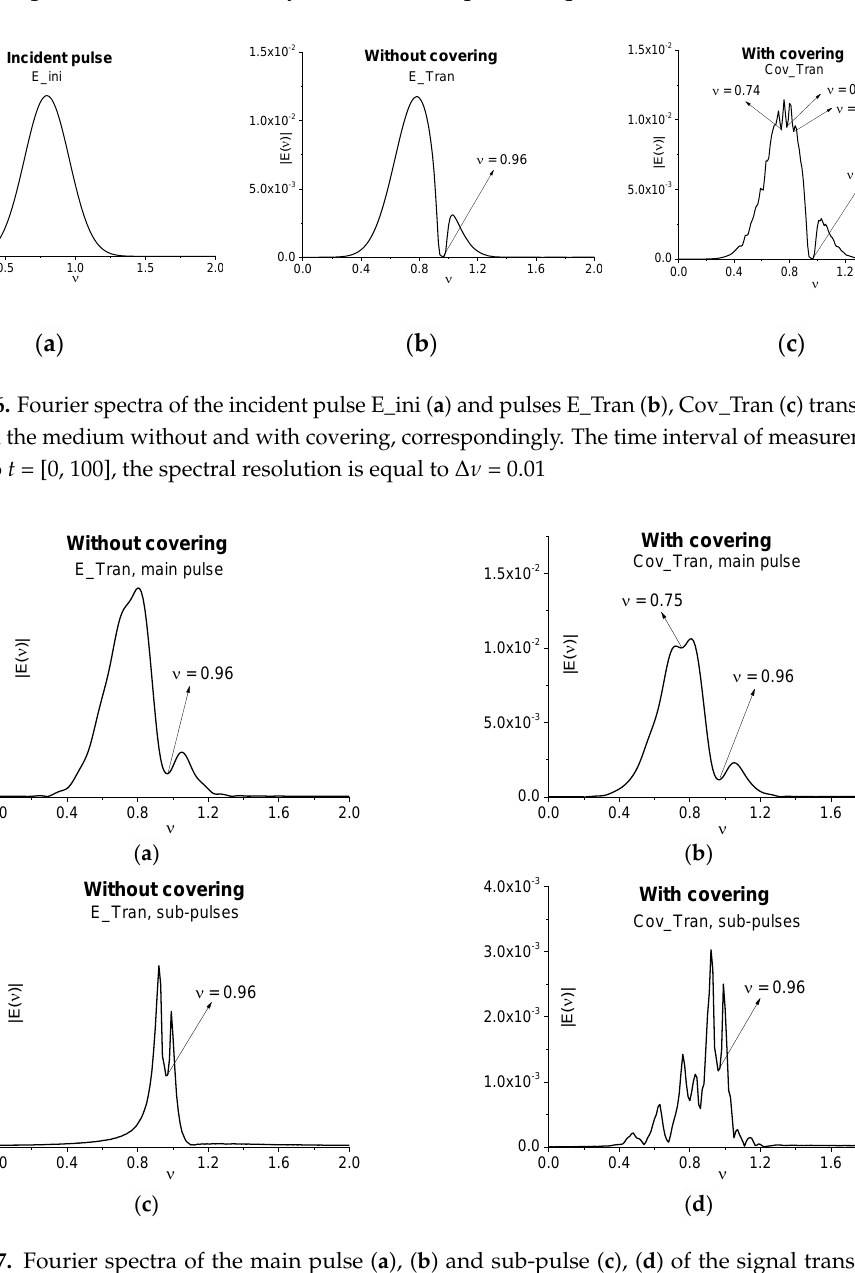
Figure 7. Fourier spectra of the main pulse ( a ), ( b ) and sub-pulse ( c ), ( d ) of the signal transmitted through the medium without (E_Tran) ( a ), ( c ) and with (Cov_Tran) covering ( b ), ( d ). The corresponding time intervals are equal to t = [0, 34] ( a ), [0, 36] ( b ), [34, 100] ( c ), [36, 100] ( d ). Spectral resolution is equal to Δν = 0.01.